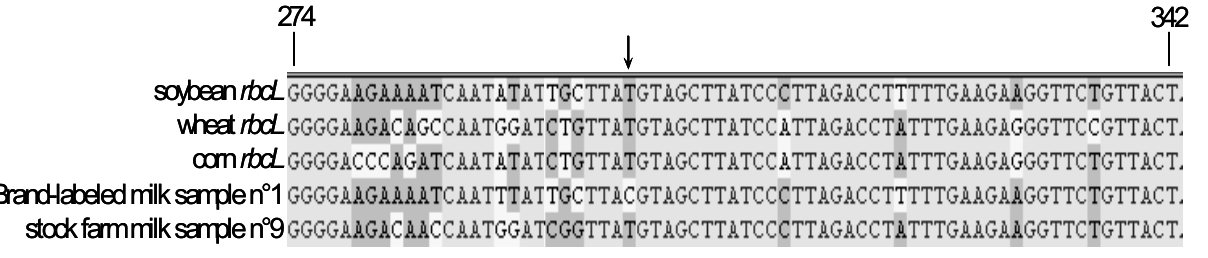
Figure 4. Multiple alignment of the rbcL sequence region comprised between nucleotide +274 trough +342 with respect to the ATG translational initiation codon, done by comparing the sequences of plant species commonly present in commercial fodders and the DNA rubisco fragments that have been amplified from n° 1 brand-labelled and n° 9 stock farm-collected cow milk samples. The arrow points to a nucleotide that is unique for the brand-labelled milk